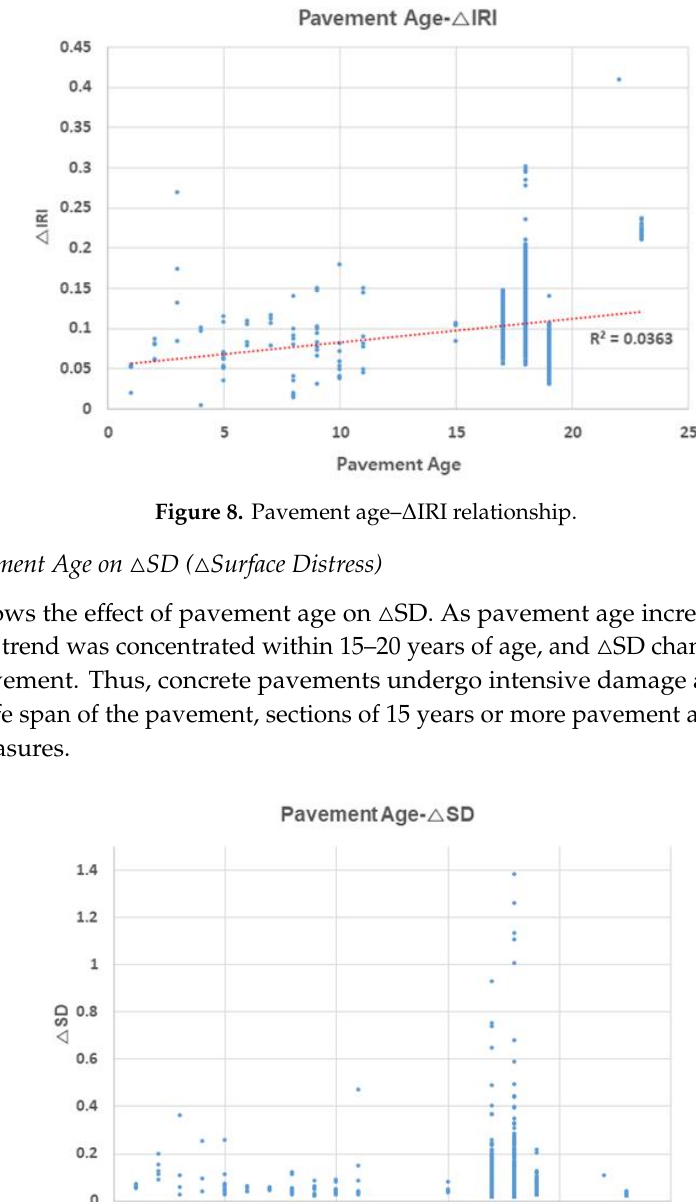
Figure 7. Traffic volume–ΔIRI relationship.